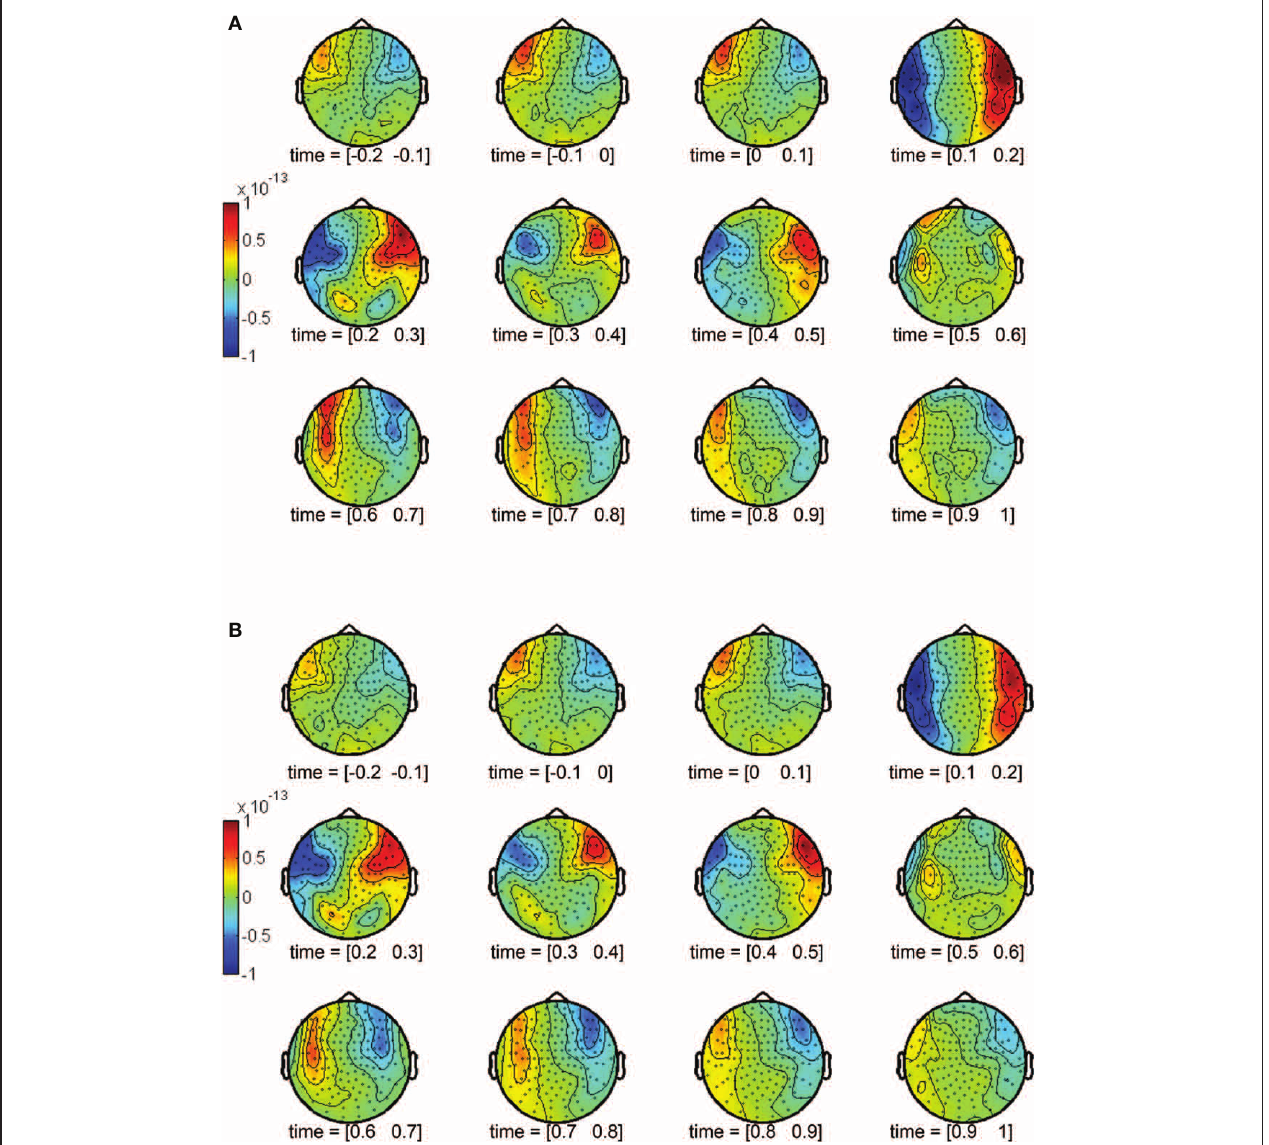
FIGURE 1 | Topographic representations of the activity in 100ms windows from 200ms prior to stimulus onset to 1s after stimulus onset. (A) Beautiful stimuli. (B) Not beautiful stimuli.